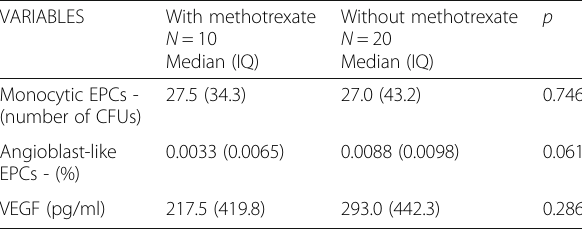
Table 5 EPCs and VEGF in Takayasu ’ s arteritis patients users and nonusers of methotrexate